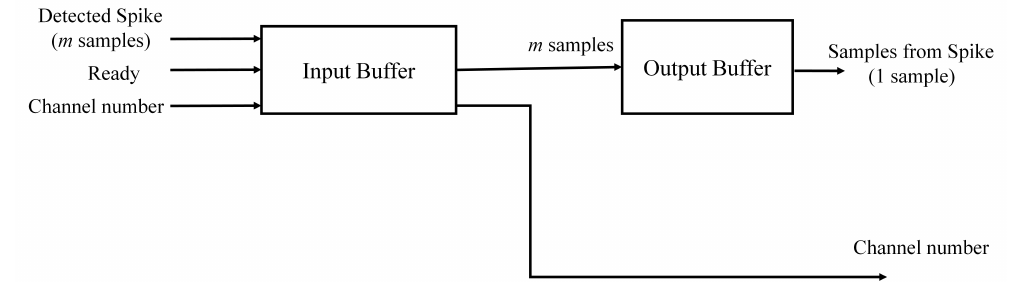
Figure 3. The block diagram of the spike buffer. It consists of the input buffer and output buffer, which are FIFO and parallel-in serial-out (PISO) buffers, respectively. The input buffer stores the detected spikes from the spike detection circuit. The output buffer delivers a detected spike to the feature extraction